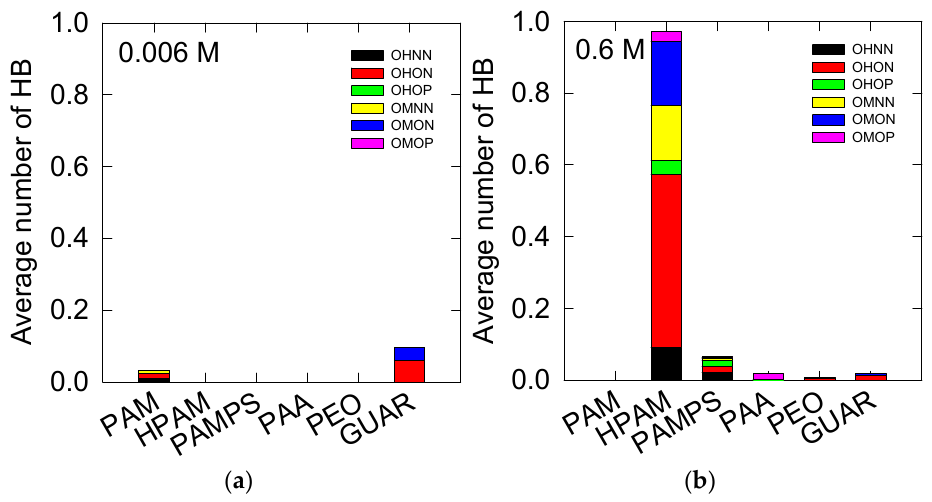
Figure 3. The time average of the HB between the polymers and the kaolinite surface (010). At salt concentrations of ( a ) 0.006 M and ( b ) 0.6 M of NaCl. OH: surface hydroxide, OM: deprotonated surface hydroxide, NN: amine polymer nitrogen, ON: neutral polymer oxygen, OP: deprotonated polymer oxygen.